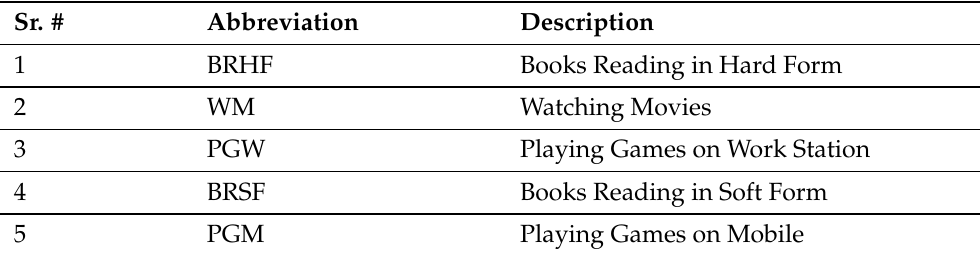
Table 1. Hobbies found in the data with eye disorder patients.